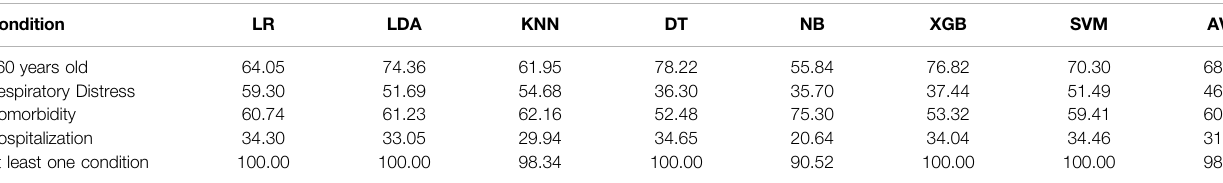
TABLE 6 | Critical conditions present in false positive